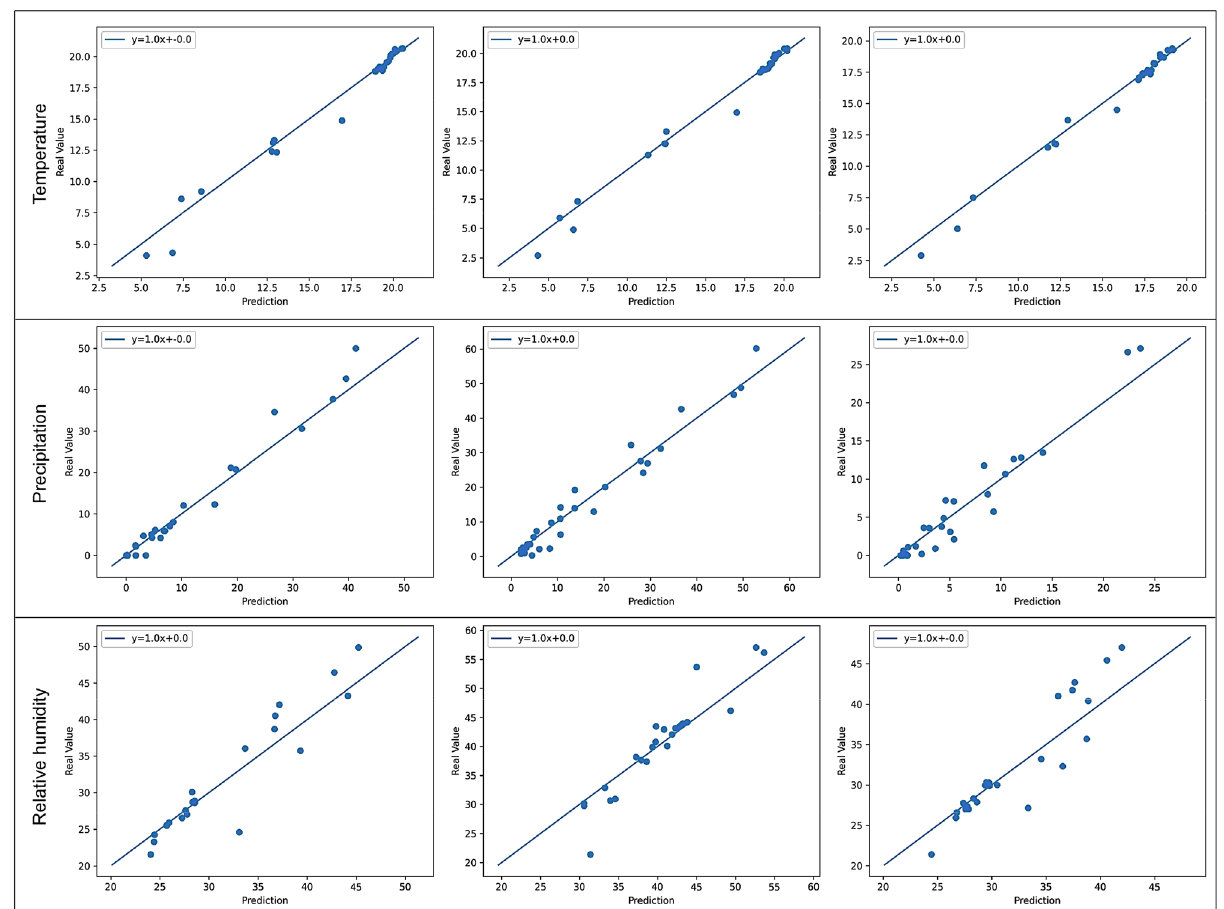
Figure 13. Plots of the estimated-versus-observed values generated by Isocompy for temperature, precipitation and relative humidity in January, February and